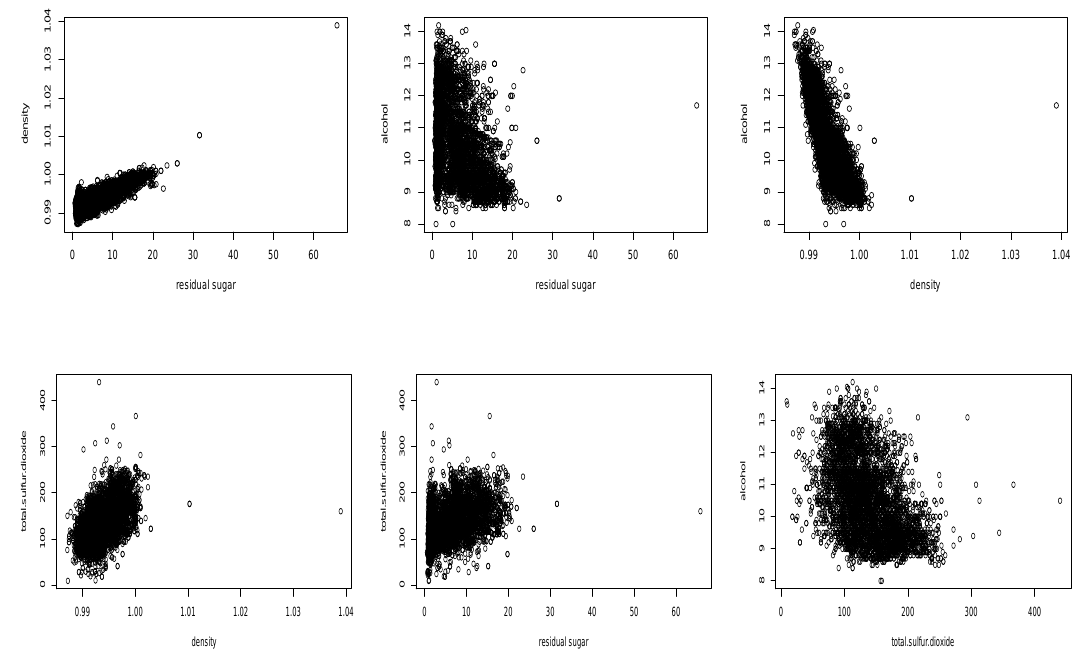
Figure 2: Scatterplots of the variables within the wine dataset: residual sugar versus density (top-left), residual sugar versus alcohol (top-center) and density versus alcohol (top-right); density versus total sulfur dioxide (bottom-left), residual sugar versus total sulfur dioxide (bottom-center) and total sulfur dioxide versus alcohol (bottom-right).